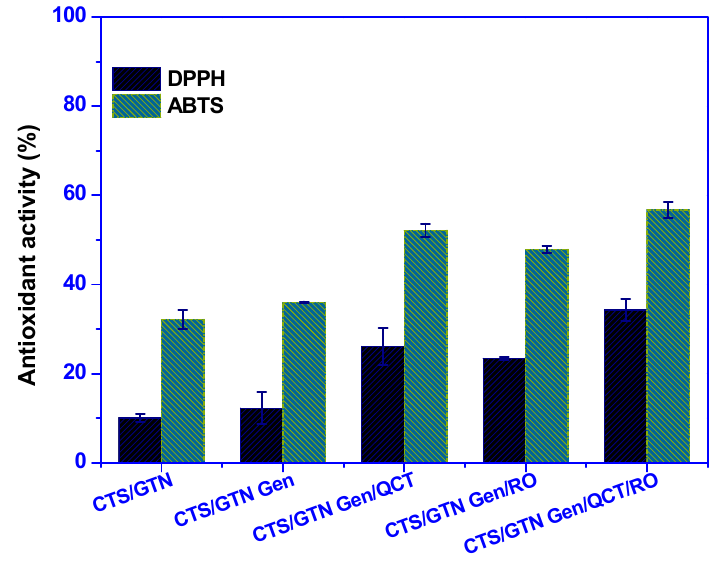
Figure 5. Antioxidant activity of the chitosan/gelatin-based films.